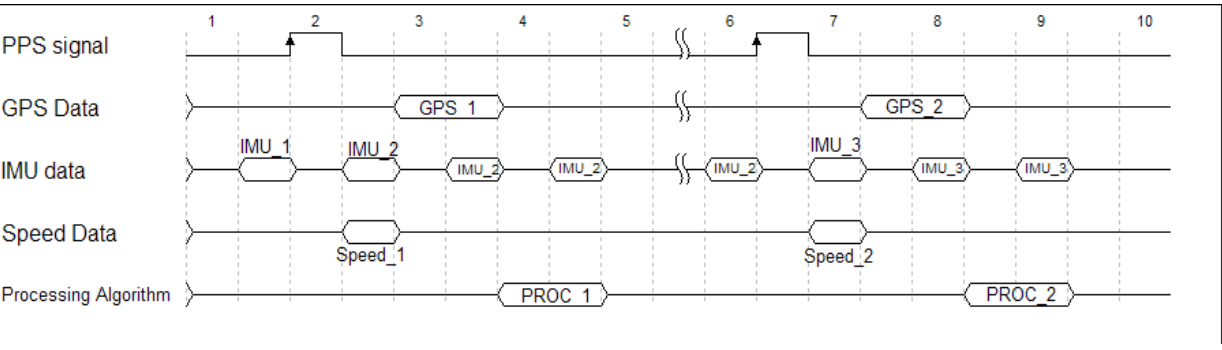
Figure 8. Timing Diagram showing the PPS Signal with respect to the GPS, IMU and speed data derived from either the odometer or the wheel